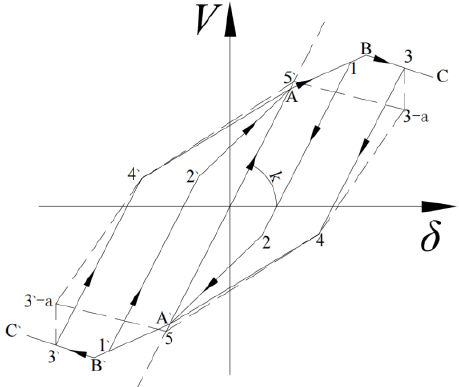
Figure 26. The SRFM for local and global coupling, distortional and global coupling destruction. Load unload rules for SRFM are assumed to be: By comparing on the hysteresis curves between the proposed SRFM and the FEA When the load is unloaded from any point 1 (or 1 ′ ) of the skeleton curve strengthen- results, the reliabilities of the proposed SRFM for CFTWS lipped channel members failed ing stage, its loading unload path is 1 → 2 → A ′ → 1 ′ → 2 ′ → A → 1. When the load is unloaded with different buckling modes can be verified. from any point 3 of the stiffness degradation stage of the skeleton curve, its loading un- 1. The comparison on the hysteresis curves between the proposed SRFM and the FEA loading path is 3 → 4 → A ′ → B ′ → 3 ′ → 4 ′ → A → B → 3. When unloaded on the second turn, its model for CFTWS lipped channel members failed with strength is shown in Figure 27. load unload path is 3-a → 4 → 5 → 3 ′ -a → 4 ′ → 5 ′ → 3-a. In the loading and unloading path, the unloading stiffness of segments 12 (1 ′ 2 ′ ) and 34 (3 ′ 4 ′ ) is the same as the initial stiffness of the skeleton curve, and the load values of point 2 and point 4 (2 ′ , 4 ′ ) are 0.2 times the load values of point 1, point 3 (1 ′ , 3 ′ ), respectively. The load values at points 3-a (3 ′ -a) are 0.7 times the load values of point 3 (3 ′ ), respectively. The load values at point 5 (5 ′ ) are 0.9